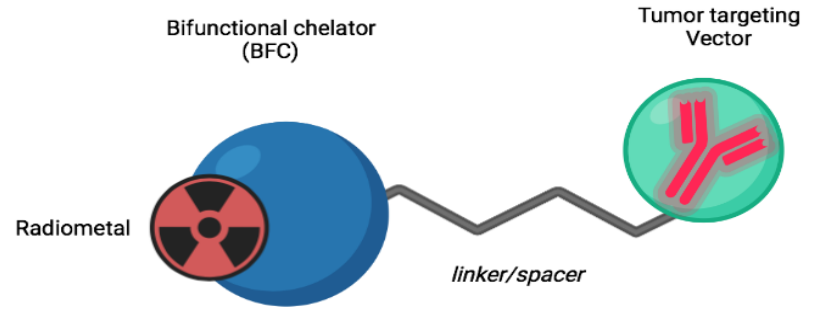
Figure 2. The design of a canonical radiopharmaceutical compound. A radiometal represents a spe- cific radionuclide. BFC stands for a chemical compound that chelates radionuclides; a linker/spacer is a link between two molecules; the tumor-targeting vector recognizes and binds a tumor biomarker to a cell.